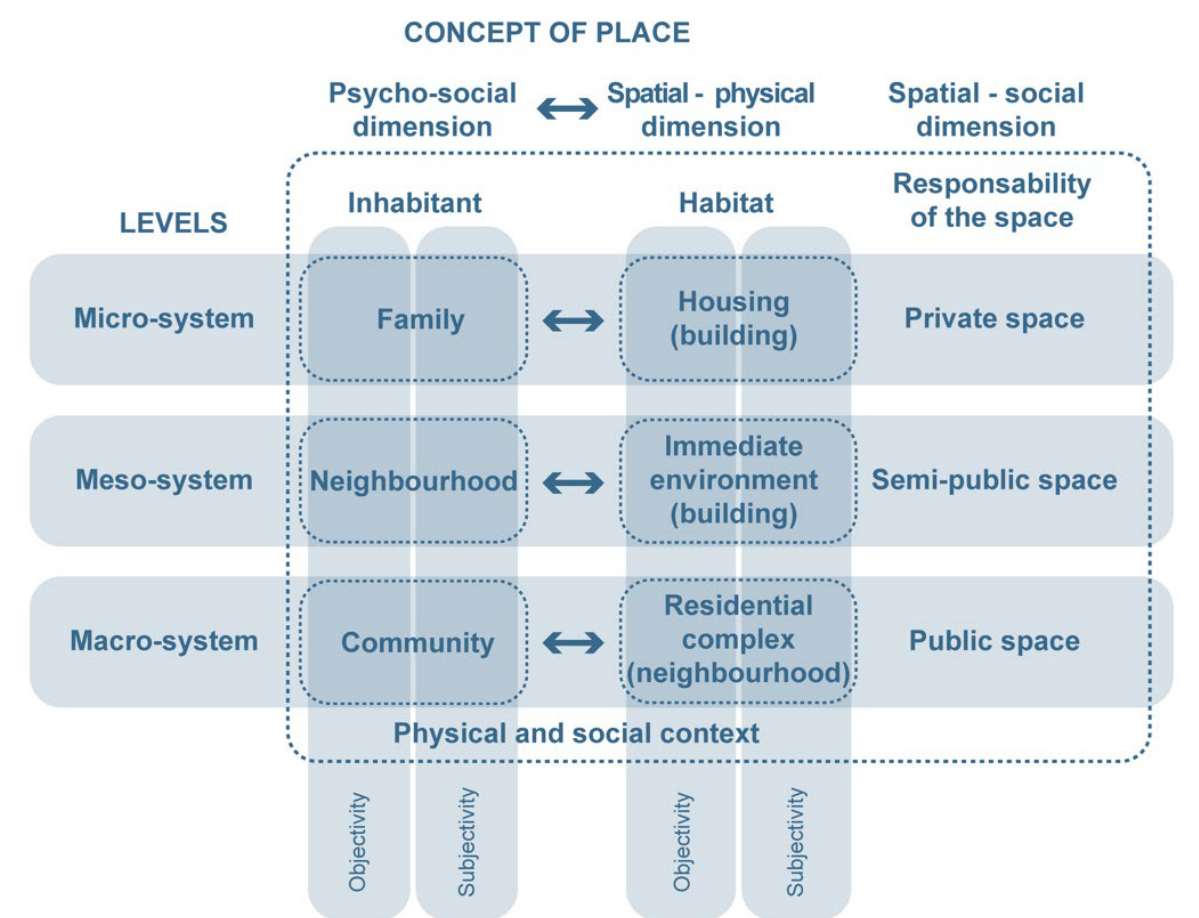
Figure 1. Connection between the psycho-social, spatial, and physical dimensions that configure the concept of a place. Source: Own elaboration, adapted from Haramoto, in Bernales (2021).